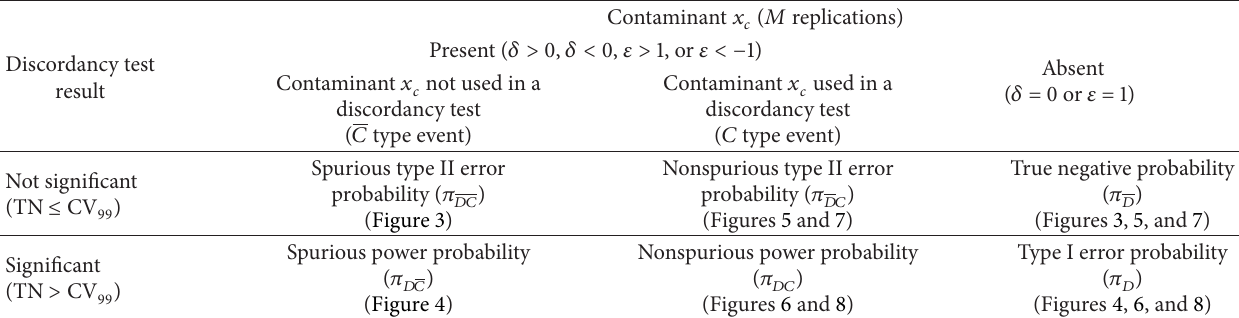
Table 1: Sample simulation and test outcome (modified after Hayes and Kinsella